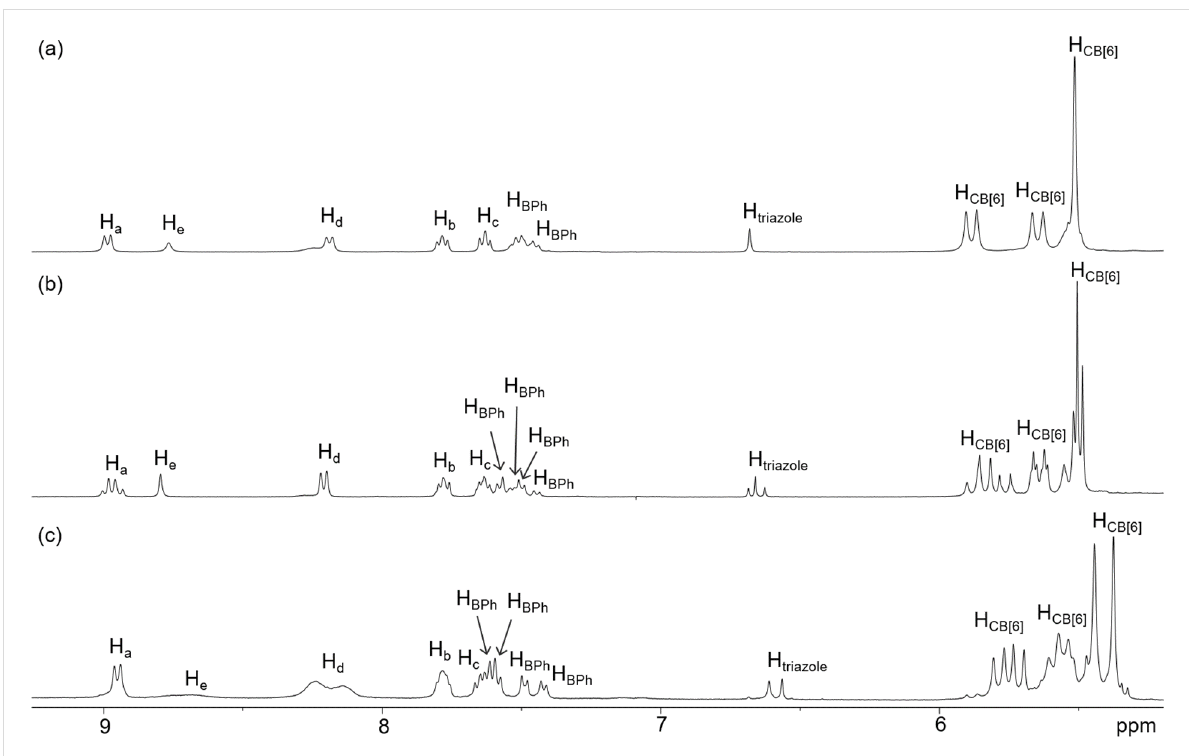
Figure 2: Partial 1 H NMR spectra (500 MHz, D 2 O, 298 K) of (a) 6R ; (b) 5R ; and (c) 4R .